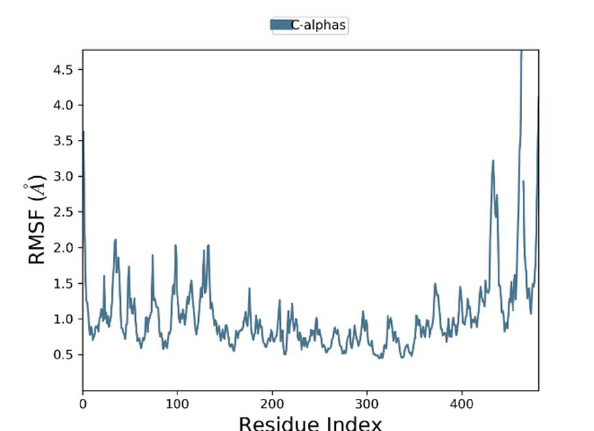
Figure 5. ( A ) MDSs trajectory output revealing the root-mean-square deviation (RMSD) plot of CMX521 bound to MNV RdRp; ( B ) Binding interaction of CMX521-MNVRdRp after MDSs; ( C ) Ligplot representing interaction of CMX521 with different residues of MNV RdRp throughout the simulation trajectory ( D ) Graphical depiction of root-mean-square fluctuation (RMSF) of CMX521 with different residues of MNV RdRp.